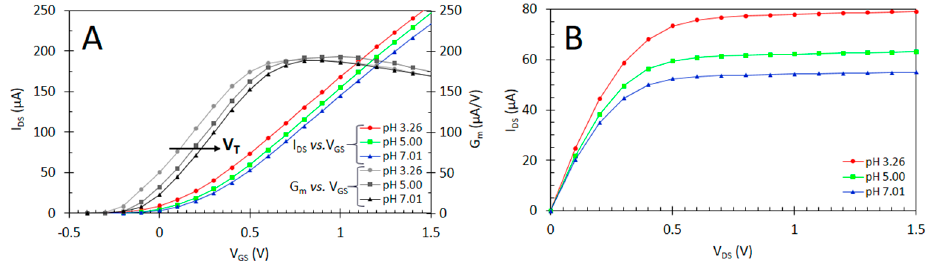
Figure 4. Influence of pH on ISFETs characteristics: ( A ) I DS vs. V GS , G m vs. V GS at V DS = 0.5 V and ( B ) I DS vs. V DS at V GS = 0.5 V using Tris/HCl buffer solutions at different pH.